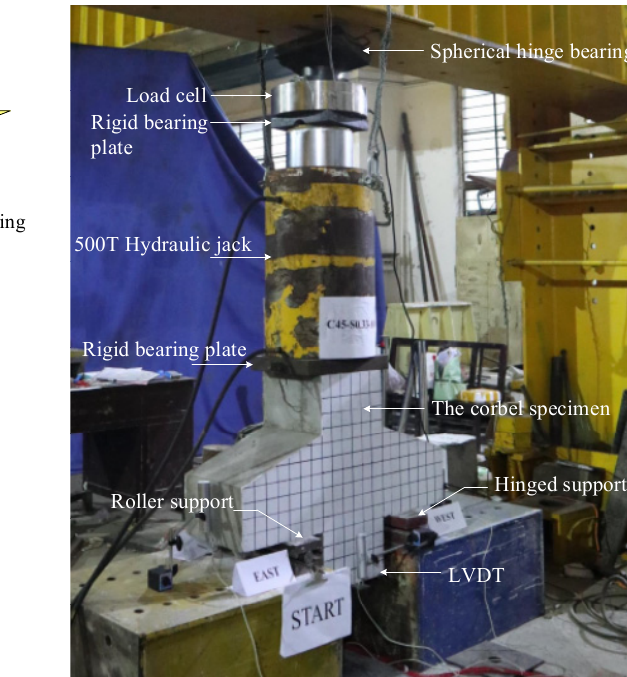
Figure 4. Typical failure mode and crack distribution (specimen C45-S0.67). An illustration is given by specimen C45-S0.67. When the load ( V ) was 247 kN (about 0.18 V t , where V t is the ultimate bearing capacity), cracks appeared at the interface between the column and the corbel. Then, the cracks developed upward along the column with the increased load. When V = 601 kN (0.44 V t ), a diagonal crack appeared in the right corbel. As the load increased, multiple diagonal cracks appeared. A similar crack development was observed in the left corbel. When V = 894 kN (0.66 V t ), the earliest diagonal crack had spread into the support and the root in both directions, and the longitudinal bars began to yield. When V = 1132 kN (0.83 V t ), all of the longitudinal bars yielded. Subsequently, the load resistance slowly rose. When V = 1358 kN (1.0 V t ), the inclined concrete was spalled and crumbled out when a huge through diagonal crack appeared. Table 4 lists the first